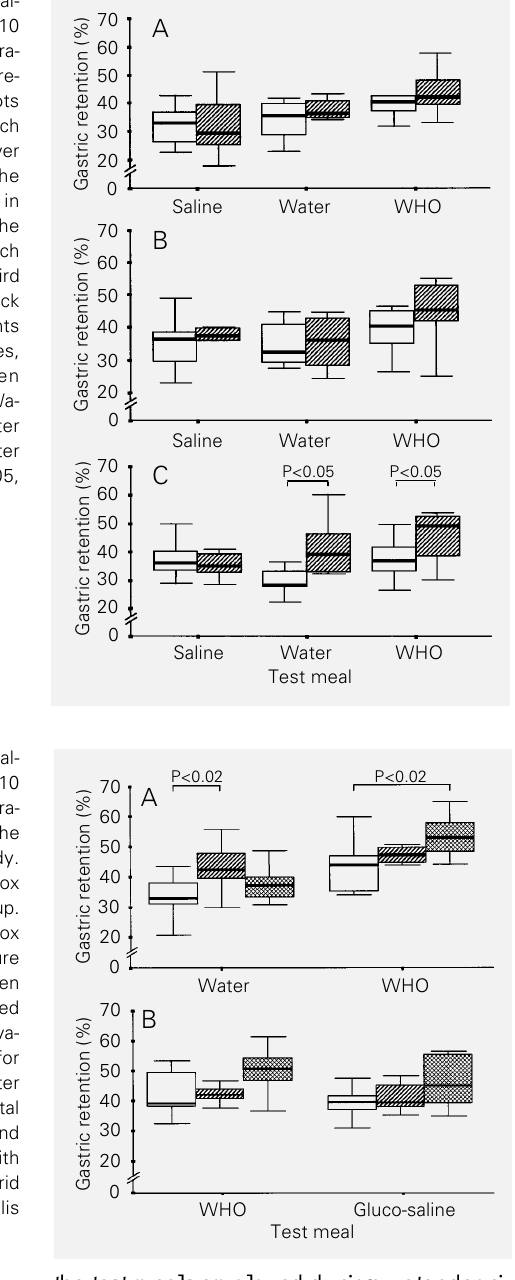
Figure 1 - Gastric retention val- ues for different test meals 10 min after orogastric administra- tion to rats (2 ml/100 g). The re- sults are presented as box plots for 10 rats in each group. In each box plot, the upper and lower horizontal lines represent the highest and lowest values in each group, respectively. The upper and lower borders of each box represent the first and third quartiles, respectively. The thick line within each box represents the median value. Striped boxes, Water-deprived rats; open boxes, non-deprived rats. A , Wa- ter deprivation for 24 h; B , water deprivation for 48 h; C , water deprivation for 72 h (P<0.05, Mann-Whitney test).